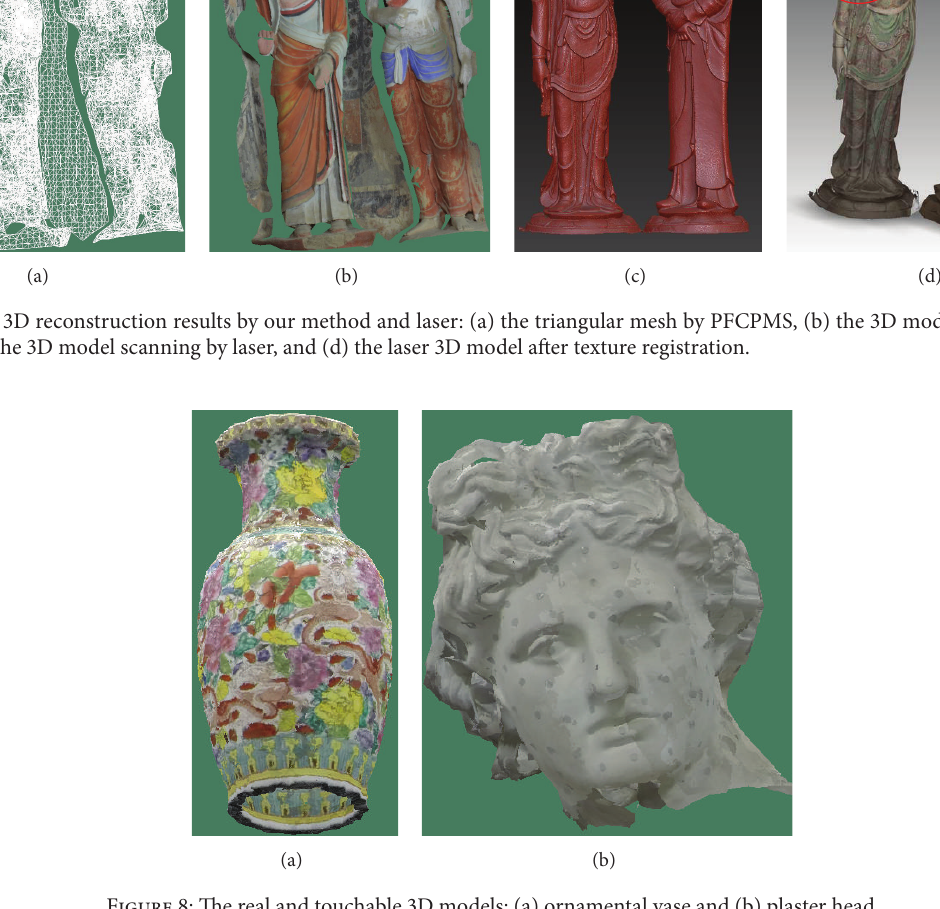
Figure 8: The real and touchable 3D models: (a) ornamental vase and (b) plaster